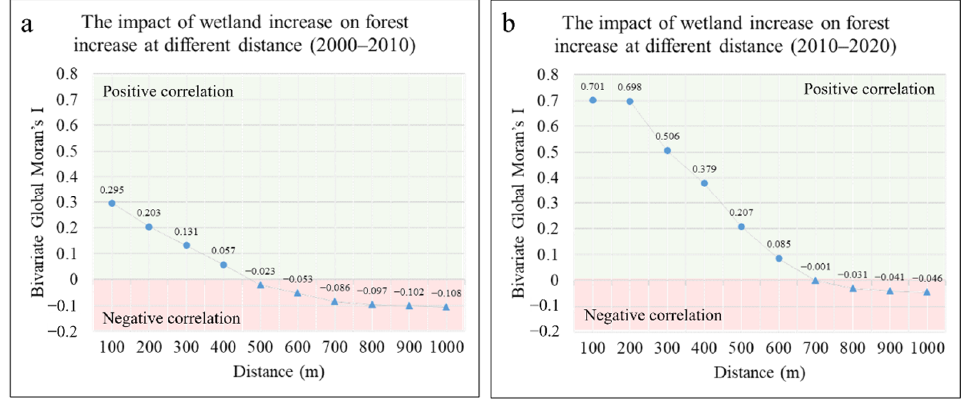
Figure 10. Bivariate Global Moran’s I between wetland increase and forest increase at different distance in Tianjin, from 2000–2010 ( a ), Bivariate Global Moran’s I between wetland increase and forest increase at different distance in Tianjin, from 2010–2020 ( b ).